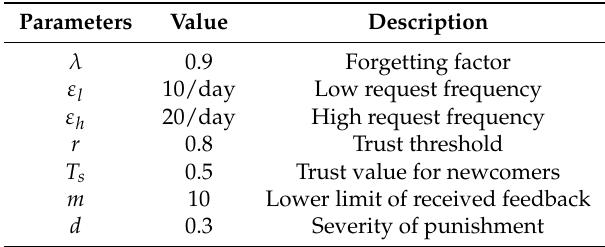
Table 1. Simulation parameters in the